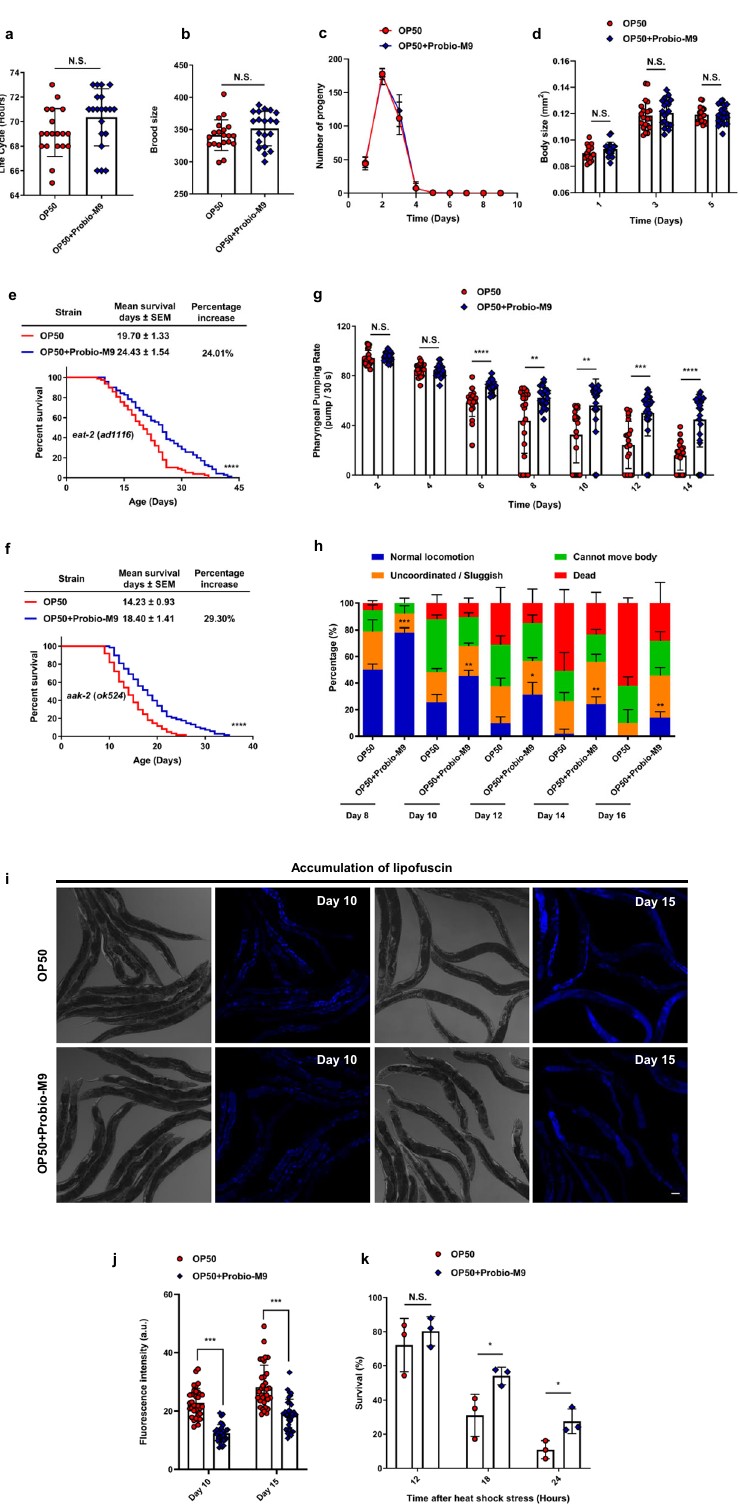
Table 4). As further con fi rmation, we explored the effect of Probio- M9 on ATF-7, a transcription factor that acts downstream of PMK- 1 in the p38 signaling pathway. Again, OP50 + Probio-M9 was unable to extend the lifespan of atf-7 ( gk715 ) mutant worms (Fig. 4f and Supplementary Table 4), suggesting that Probio-M9 might activate ATF-7 through PMK-1 to extend the lifespan of C. elegans